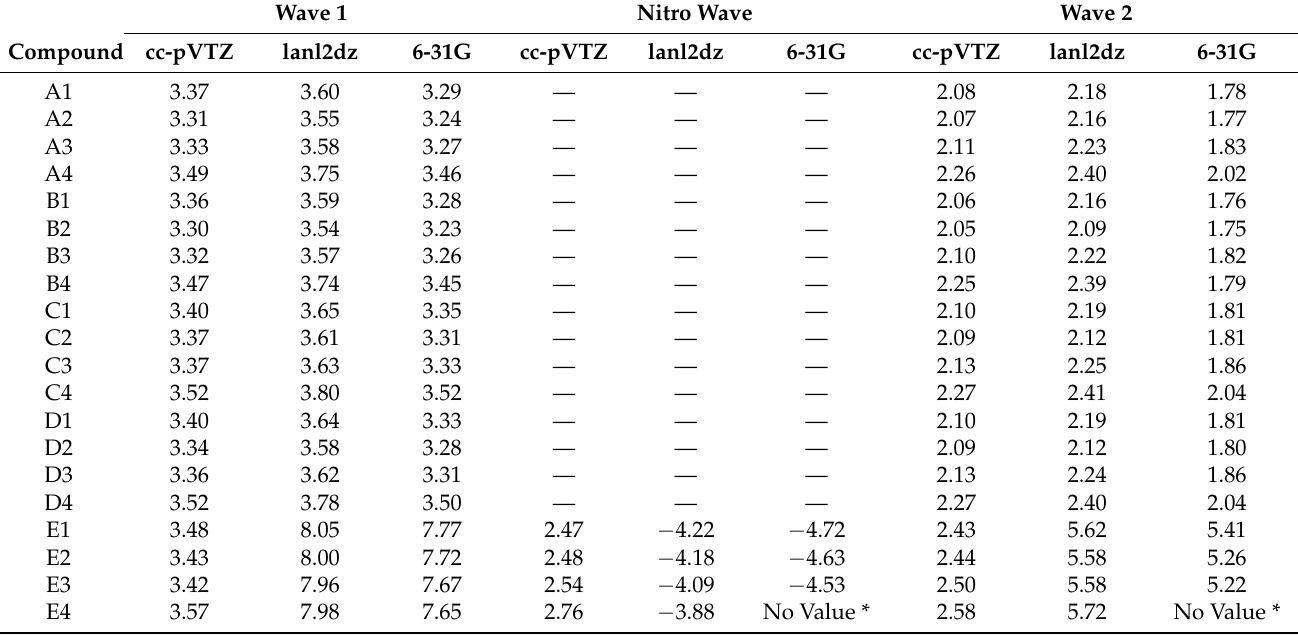
Table 2. Wave 1, nitro wave, and wave 2 half-cell reaction potentials (in volts) calculated using B3LYP/cc-pVTZ and the previously calculated B3LYP/lanl2dz and B3LYP/6-31G predictions [27].